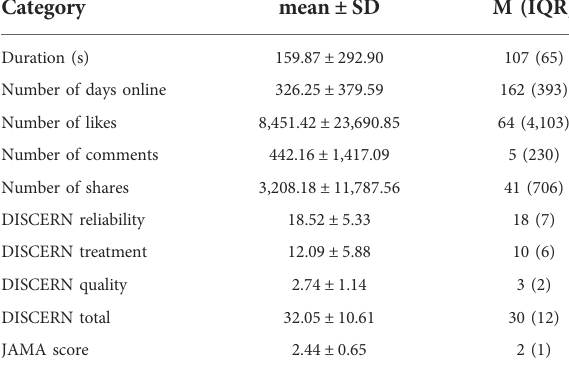
TABLE 1 General characteristics and scores of the understudied